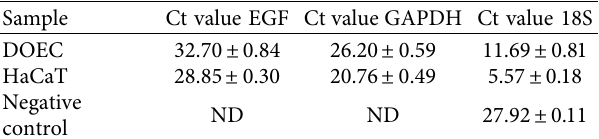
Table 1: Ct values for the epidermal growth factor (EGF), glyc- eraldehyde 3-phosphate dehydrogenase (GAPDH), 18S ribosomal RNA (18S) in negative controls (RNAse-free water), and RNA samples for DOECs and HaCaTcells. Gene expression was assessed in DOECs isolated from all 4 individuals included in the study. Values are presented as means ± SEM for three experiments. ND: not